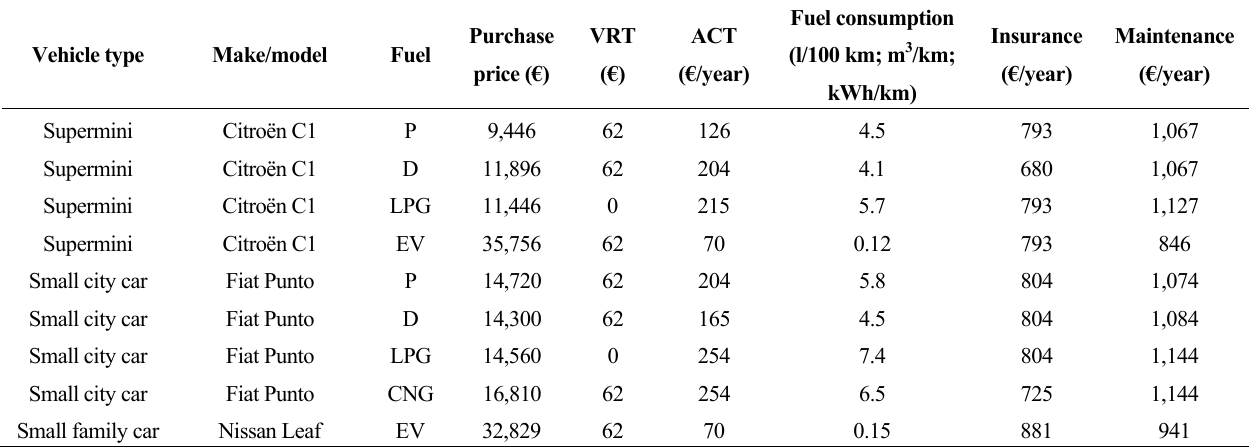
Table 1. Key cost